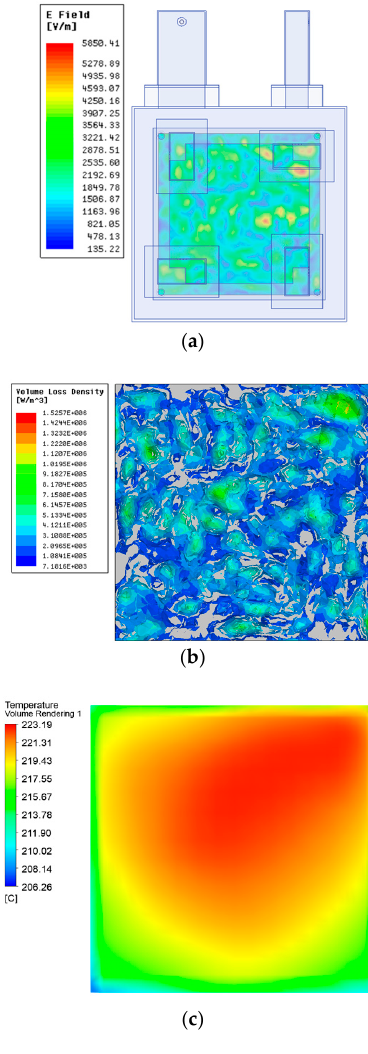
Figure 5. Electric field ( a ), volume loss density ( b ) and temperature distribution ( c ) results on the glass surface in accordance with the glass-heating system shown in Figure 4, with a graphite susceptor.